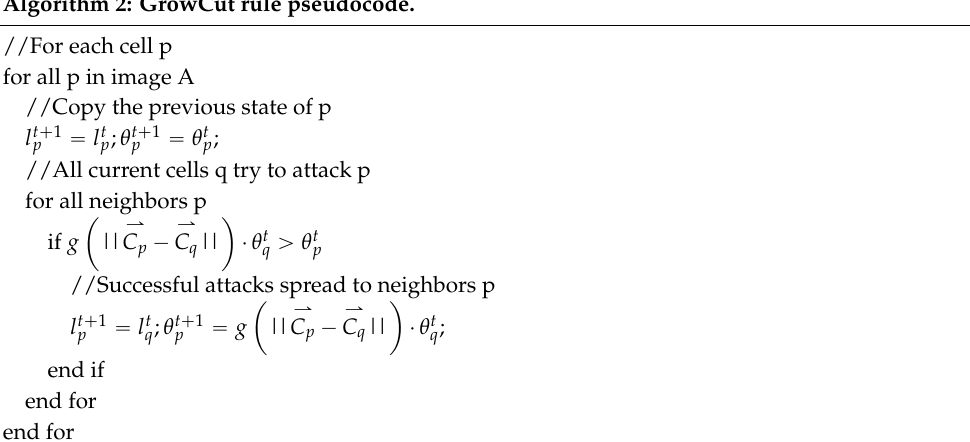
Algorithm 2: GrowCut rule pseudocode.